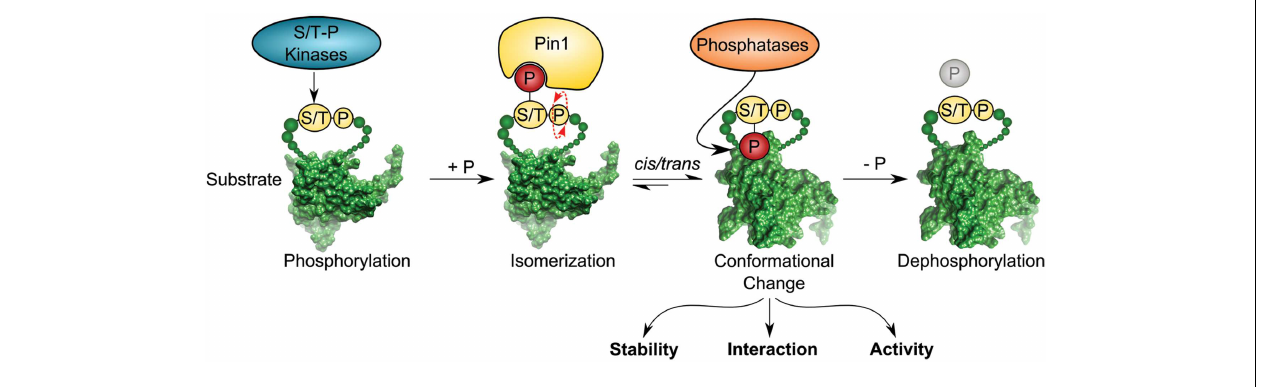
subsequent step. Isomerization can regulate different functions of the substrate, such as stability, interaction, and activity. Pro-directed phosphatases, such as PP2A can dephosphorylate the pSer/Thr–Pro isomer [depicted substrate has been downloaded from PDB database; Protein-ID: 2FEJ